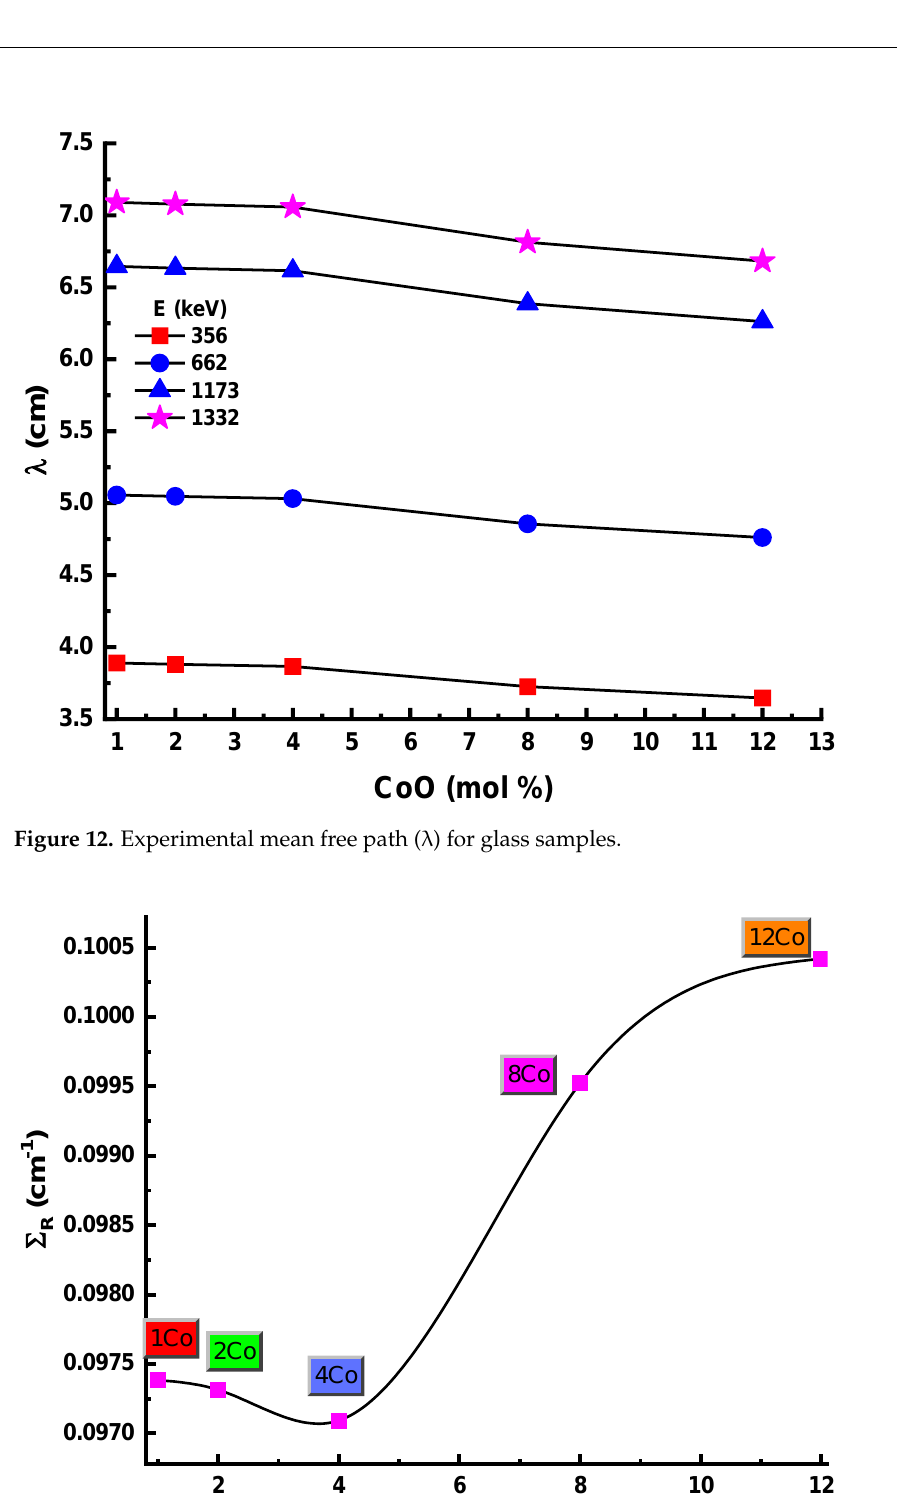
Figure 11. Comparison of experimental half-value layer (T 1/2 ) value of the 12Co sample with both